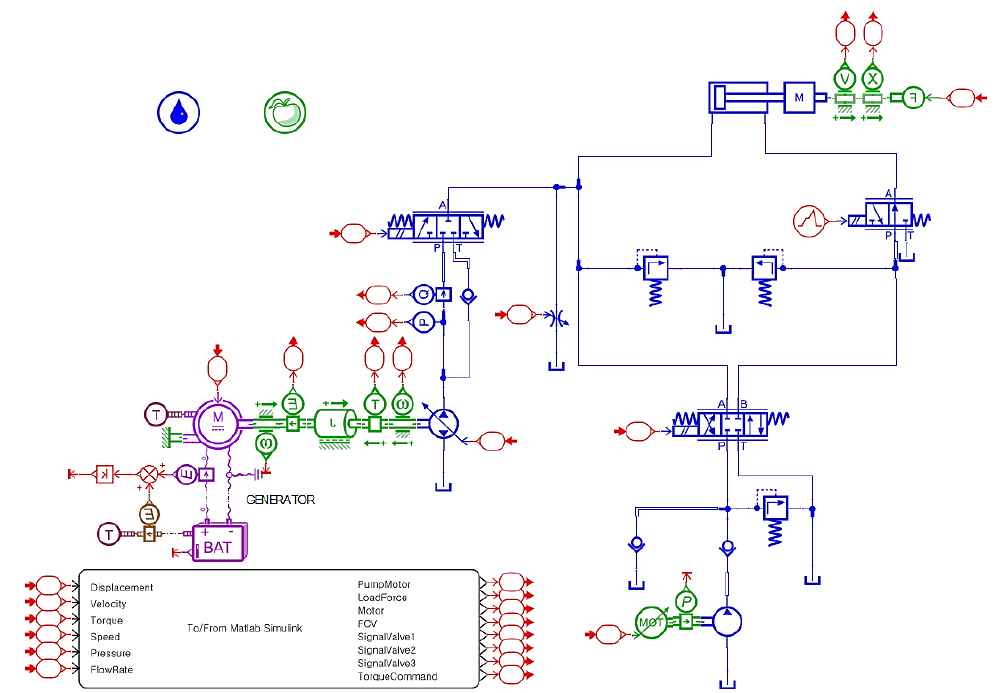
Figure 8. The proposed simulation model in AMESim software.